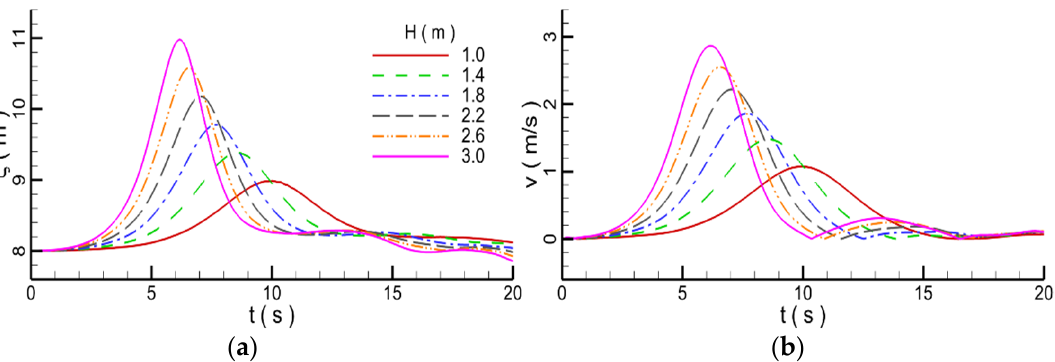
Figure 19. The temporal evolution of the water level and the velocity; ( a ) the water level; ( b ) the velocity.